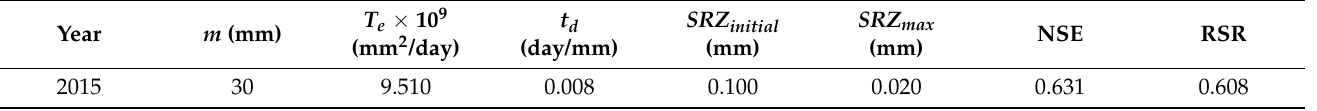
Table 1. The best performing parameter sets of the Atari River catchment during the calibration